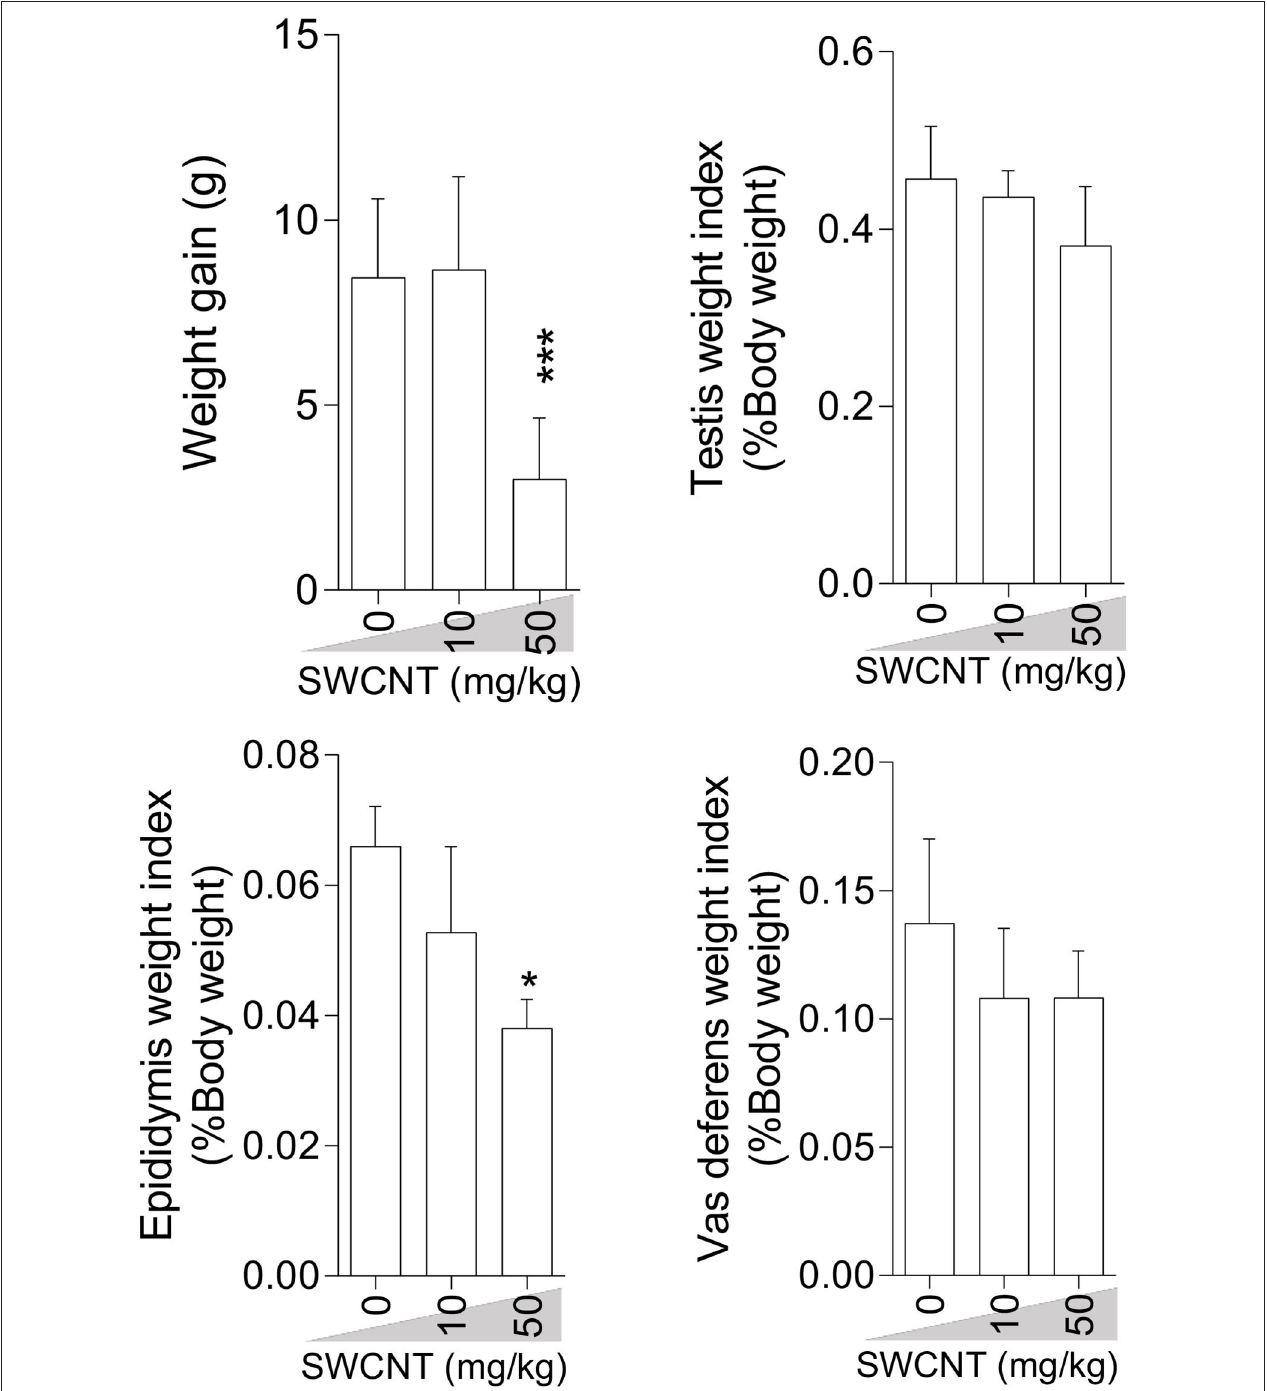
FIGURE 1 | Effect of single-walled carbon nanotubes (SWCNT) on body weight gain and reproductive organ weight index in mice (mean ± SEM, n = 6). Asterisks indicate significantly different from the control (0 ppm) group (* P < 0.05, *** P < 0.001).